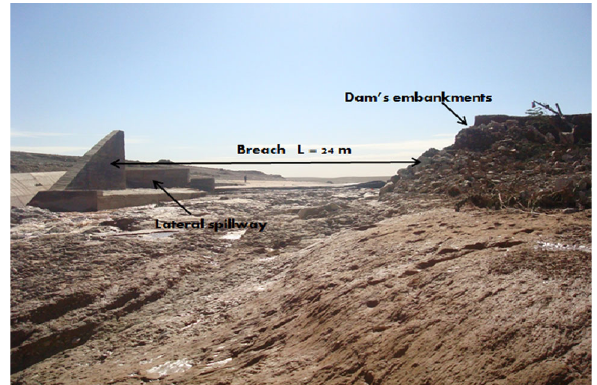
Fig. 2 Damages recorded in spillway’s zone—October